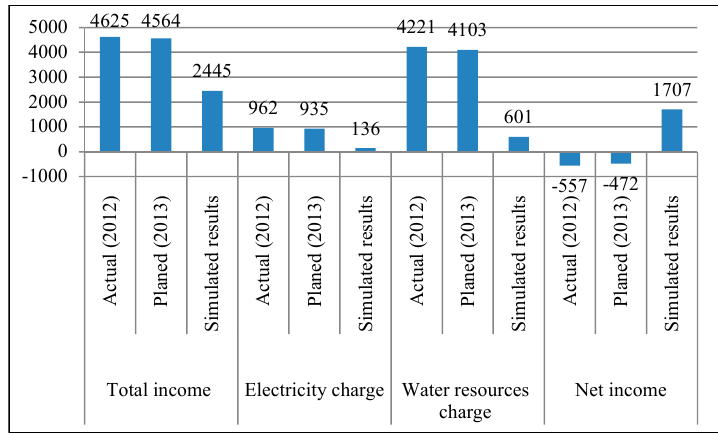
Figure 18. The total income, water resources fee and net income of Beibu during the period from 3.2 to